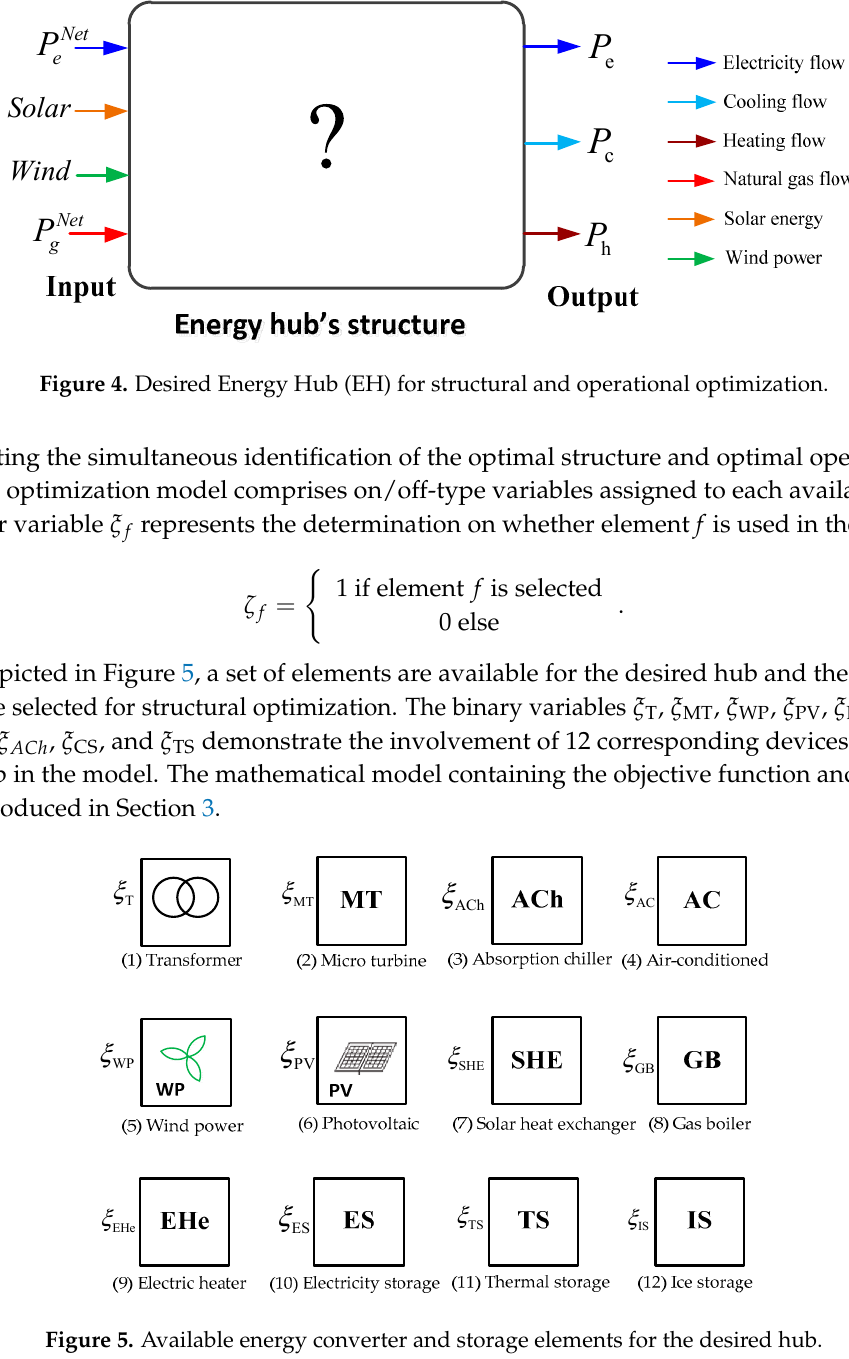
Figure 5. Available energy converter and storage elements for the desired hub.